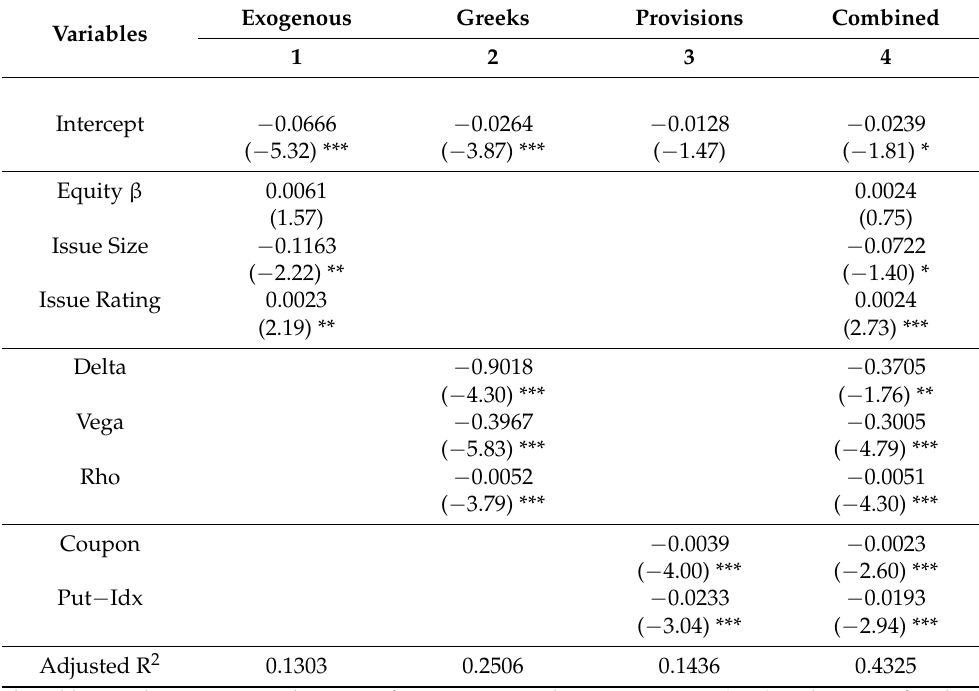
Table 6. Cross-sectional analysis of relative pricing error ( RPE